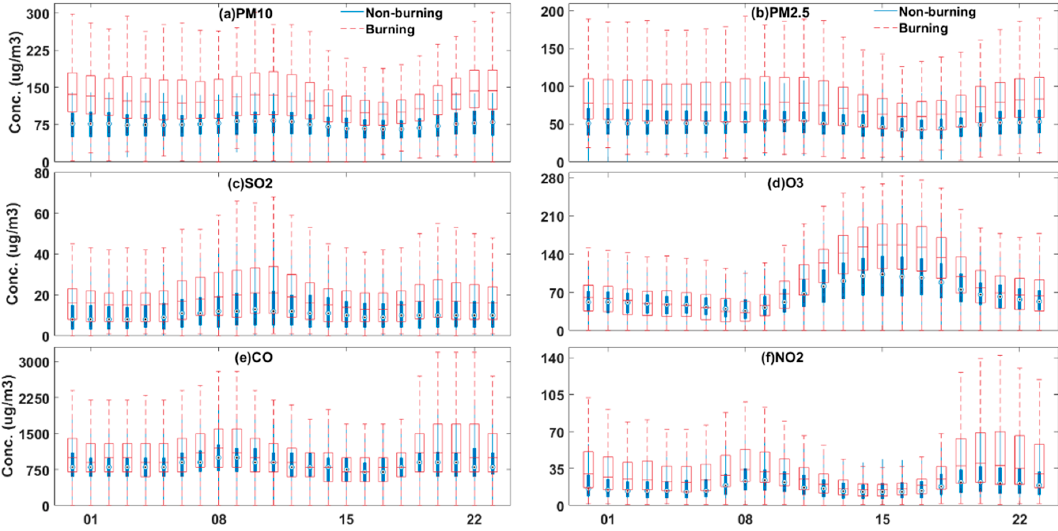
Figure 5. Examples of the average diurnal variation of PM 10 ( a ), PM 2.5 ( b ), SO 2 ( c ) O 3 ( d ), CO ( e ) and NO 2 ( f ) concentrations during the Burning and Non-burning periods.